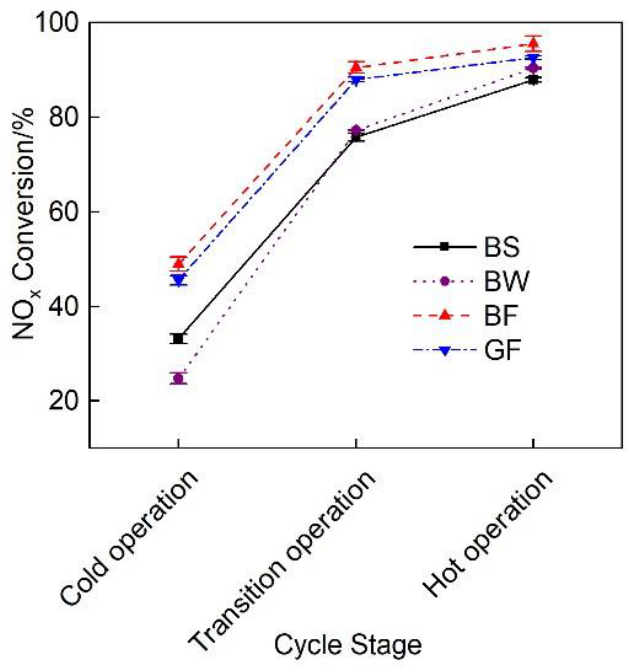
Figure 7. NO x conversion rate of the different exhaust pipe covering schemes.